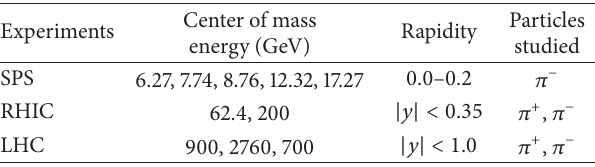
Table 1: The center of mass energy and rapidity of the data used for the study. Center of mass Particles Experiments Rapidity energy (GeV) studied SPS 6.27, 7.74, 8.76, 12.32, 17.27 0.0–0.2 RHIC 62.4, 200 LHC 900, 2760, 700 |𝑦| < 1.0 𝜋 + , 𝜋 −